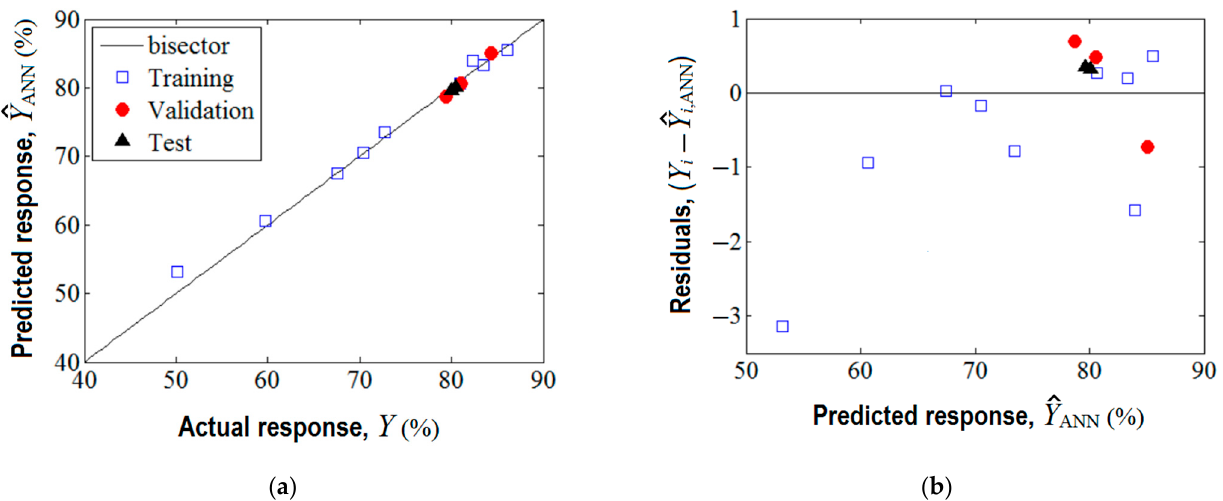
Figure 5. Agreement between experimental data and ANN model: ( a ) ANN output (predicted response) vs. actual response (target), ( r 2 = 0.994); ( b ) residual analysis: residual errors against LC predicted response ( ˆ Y ANN )